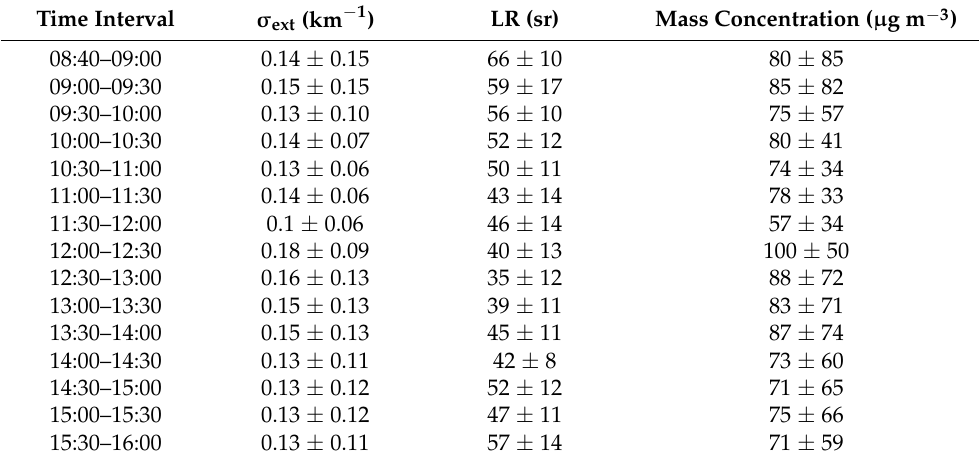
Table 3. Mean aerosol extinction coefficients, LIDAR ratios (LRs) at 532 nm and mass concentrations in the PBL (0–2 km) for each time interval corresponding to the transect segments depicted in Figure 4a. The standard deviations correspond to the spatio-temporal variability within each transect